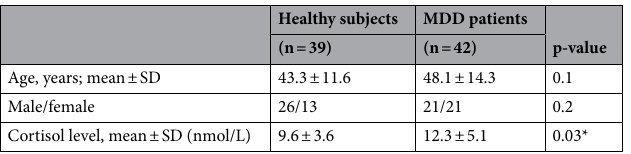
Table 1. Demographic characteristics and values of serum cortisol of participants. SD, standard deviation, MDD, major depression disorders. *Significant